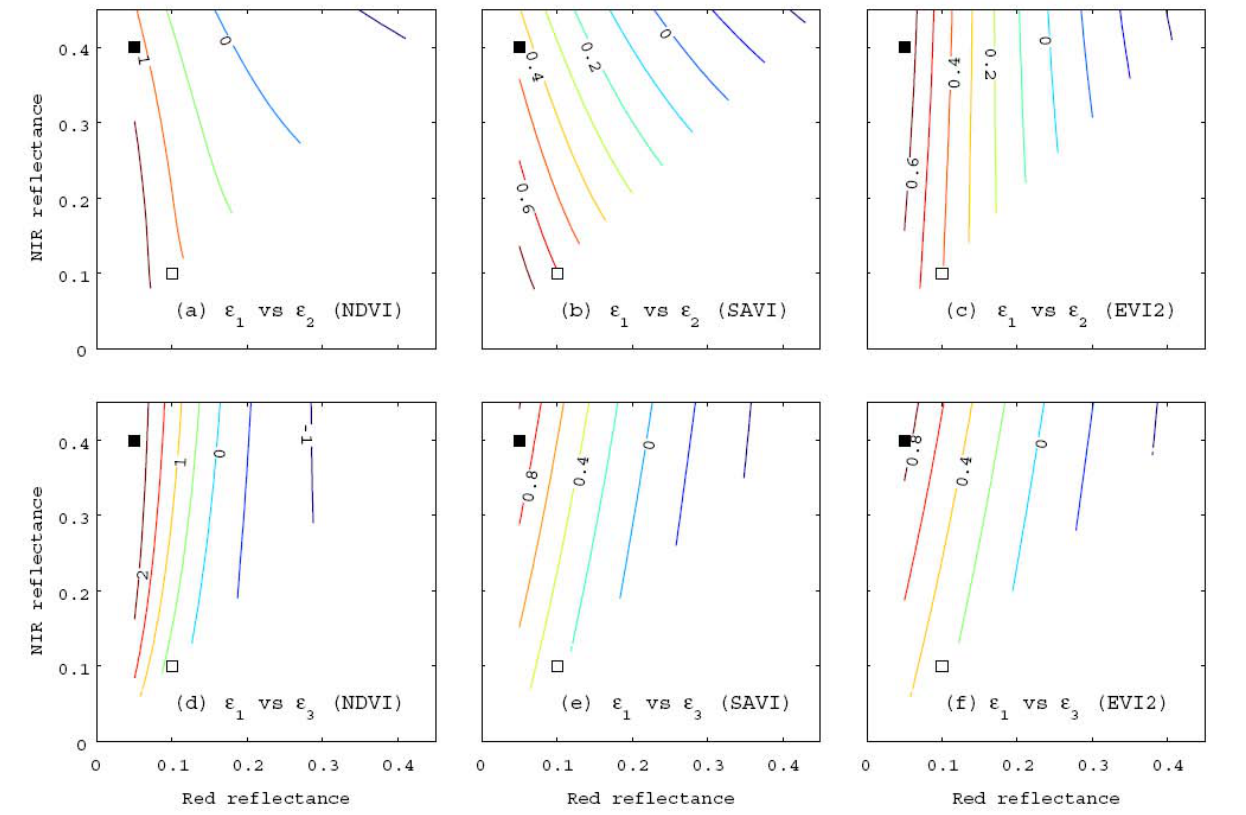
Figure 10. Results of numerical simulations obtained by replacing the endmember spectra EM1 with EM2, shown with respect to those used in previous calculations, Figure 9. The results indicate that the relationship is influenced by the choice of VI as well as endmember spectra (non-vegetation class). A comparison with previous results is also shown. ( a – c ) show tan θ -map for algorithm-1 and -2 using NDVI, SAVI, and EVI2 as the 0